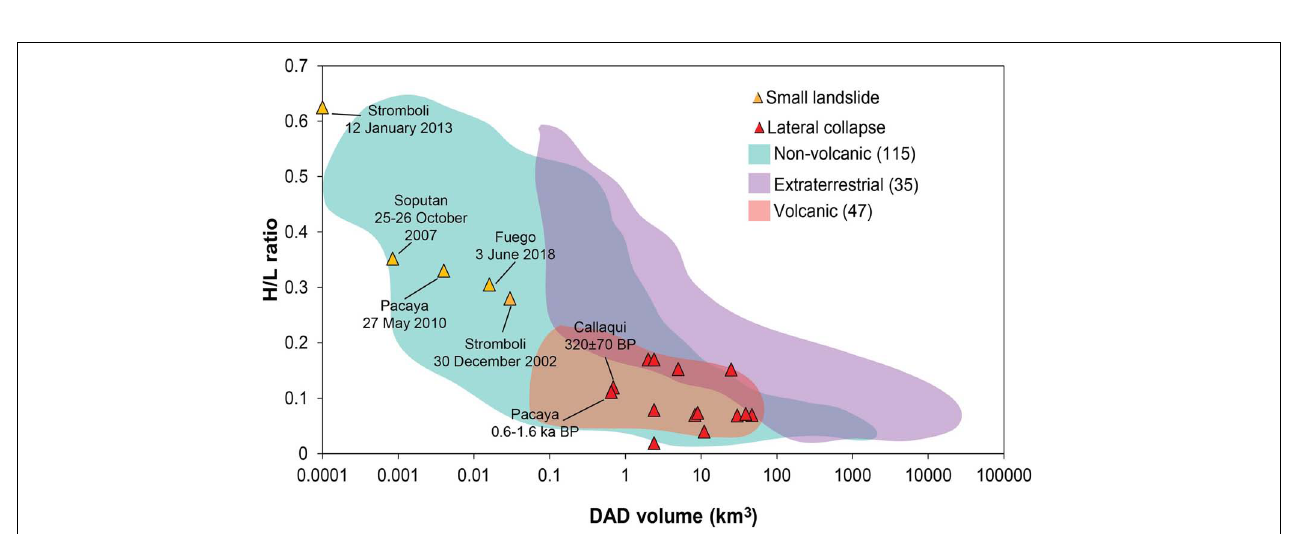
FIGURE 9 | Plot of the H/L ratio v/s volume for VDAD deposit sourced from basaltic volcanoes. The field for non-volcanic and planetary landslides is indicated. The plot and fields are modified from van Wyk de Vries and Davies (2015). Original data is found in Supplementary Table 2 . All small landslides in mafic volcanes fall in the field of non-volcanic landslides, while all sector collapses are in the same field than any other sector collapse irrespectively of the composition of the failed volcanic edifice.